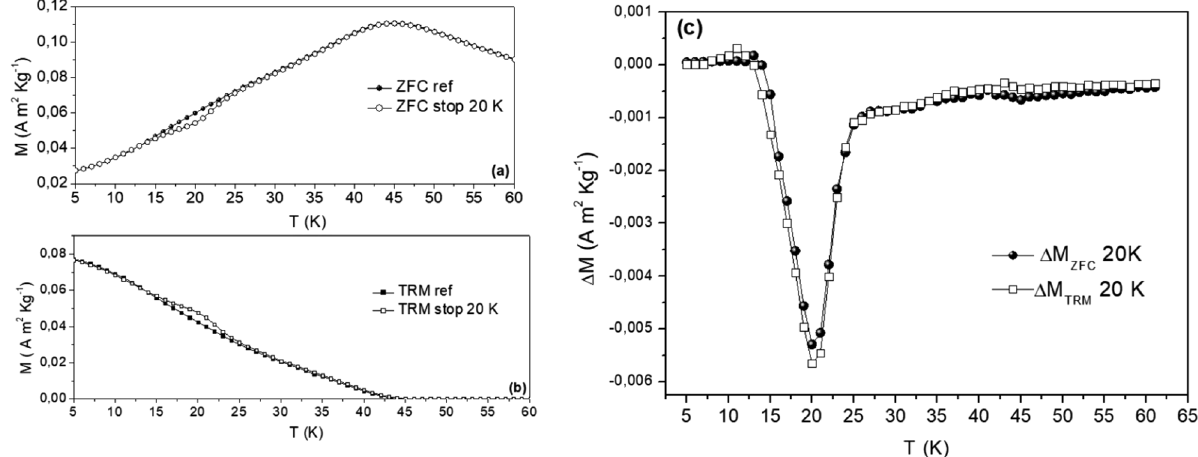
Figure 3. ( a ) ZFC and ( b ) TRM magnetizations for H = 100 Oe. Two curves ZFC and TRM measured after a t h = 10800 s halt at T h = 20 K during cooling are added; ( c ) difference with the corresponding reference curves.